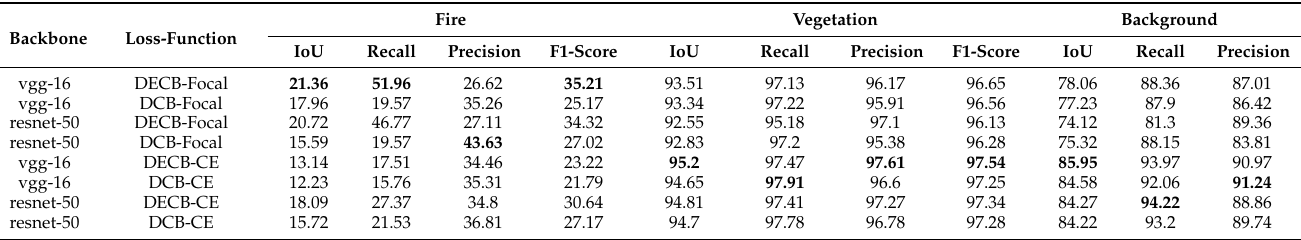
Table 8. Results of the evaluation of the forest fire burning area dataset (%).